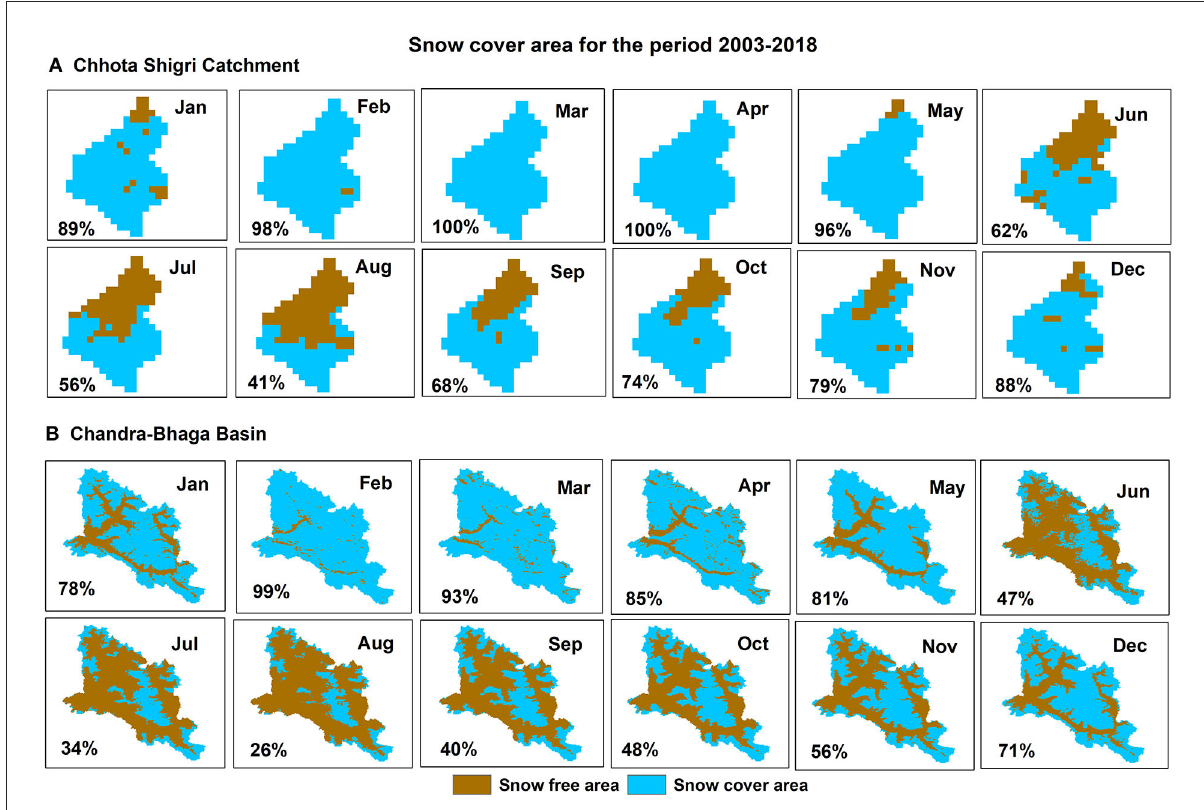
FIGURE4 Mean monthly variation of SCA for Chhota Shigri Catchment (A) and Chandra-Bhaga Basin (B) over 2003–2018. Maps of both the areas are not on the same